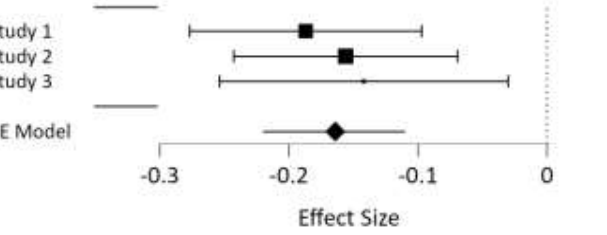
Figure 3 . Forest plot of meta-analysis of Amotivation and Agreeableness